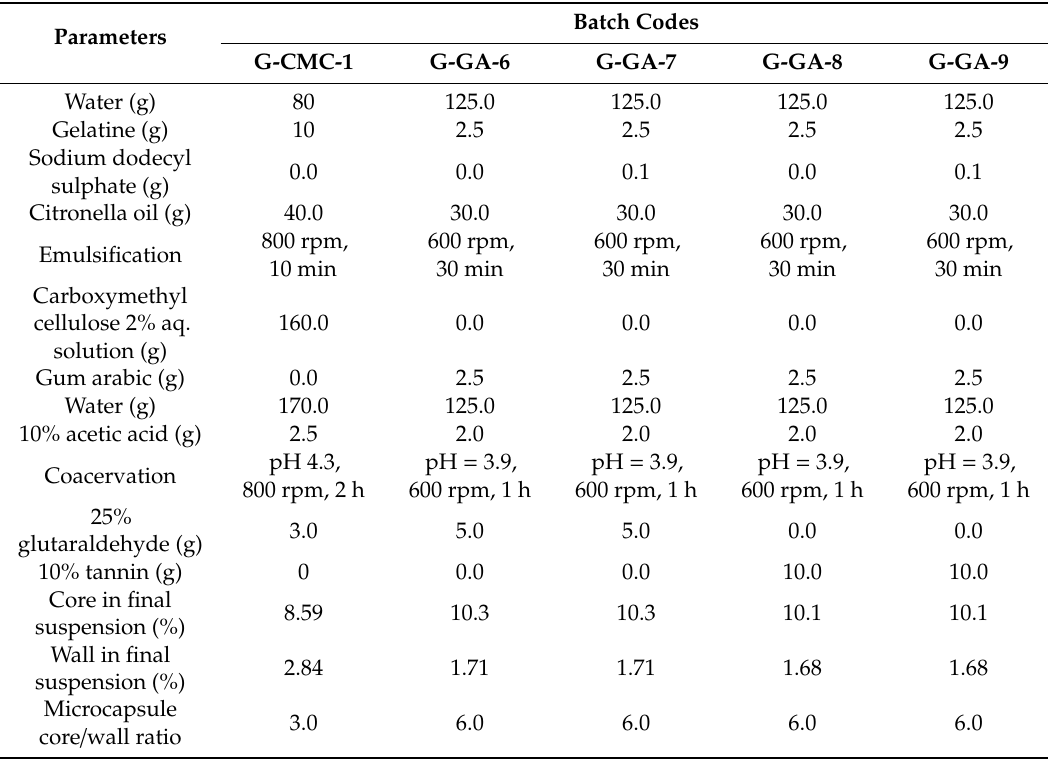
Table 4. Experimental parameters of citronella oil complex coacervation microencapsulation